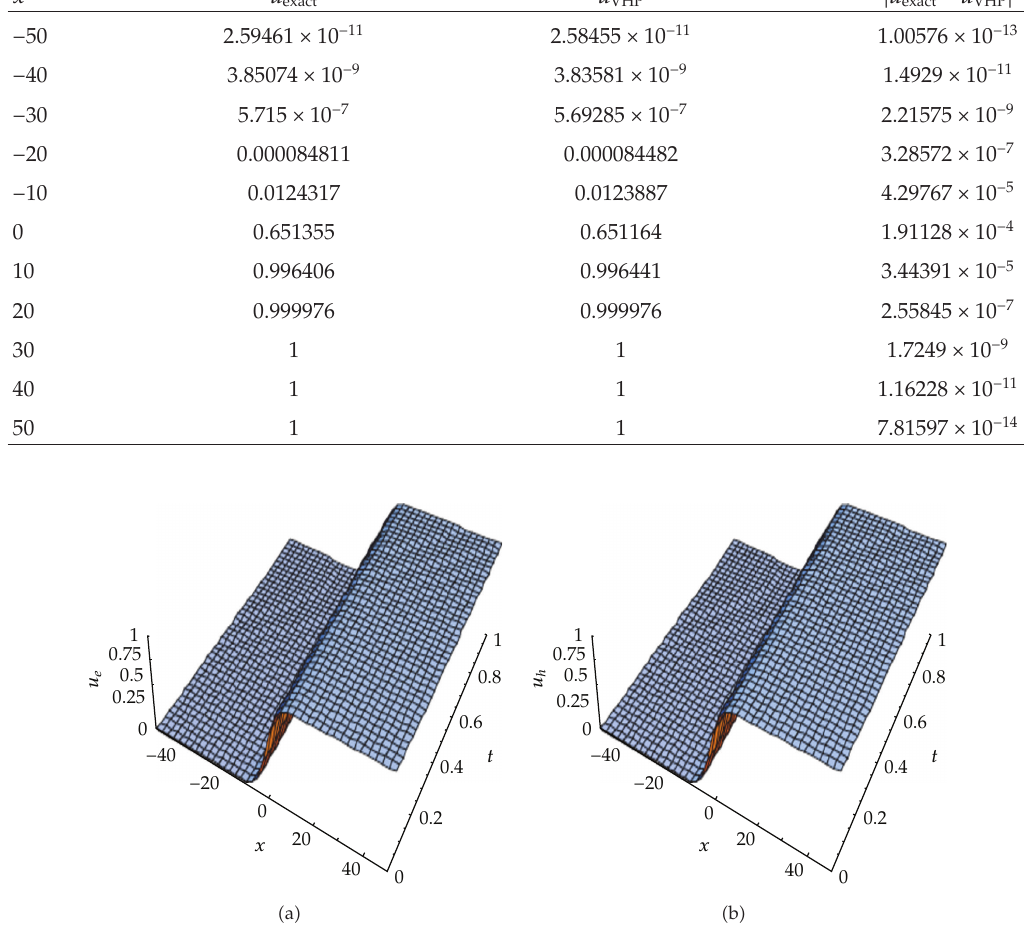
Figure 1: The approximate solution (cid:2) 5.6 (cid:3) shown in (cid:2) b (cid:3) in comparison with the exact solution (cid:2) 5.2 (cid:3) shown in (cid:2) a (cid:3) if t (cid:7) 0 .